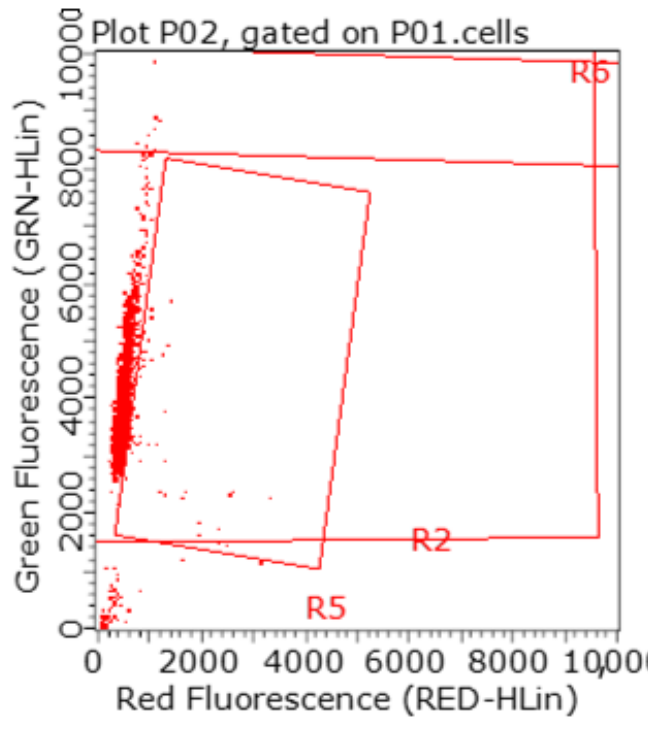
Figure 10. An example of a dot plot with 3.39 percent of spermatozoa with DNA fragmentation in the red rectangle in the Experimental group, determined according to the DNA fragmentation index (% DFI).